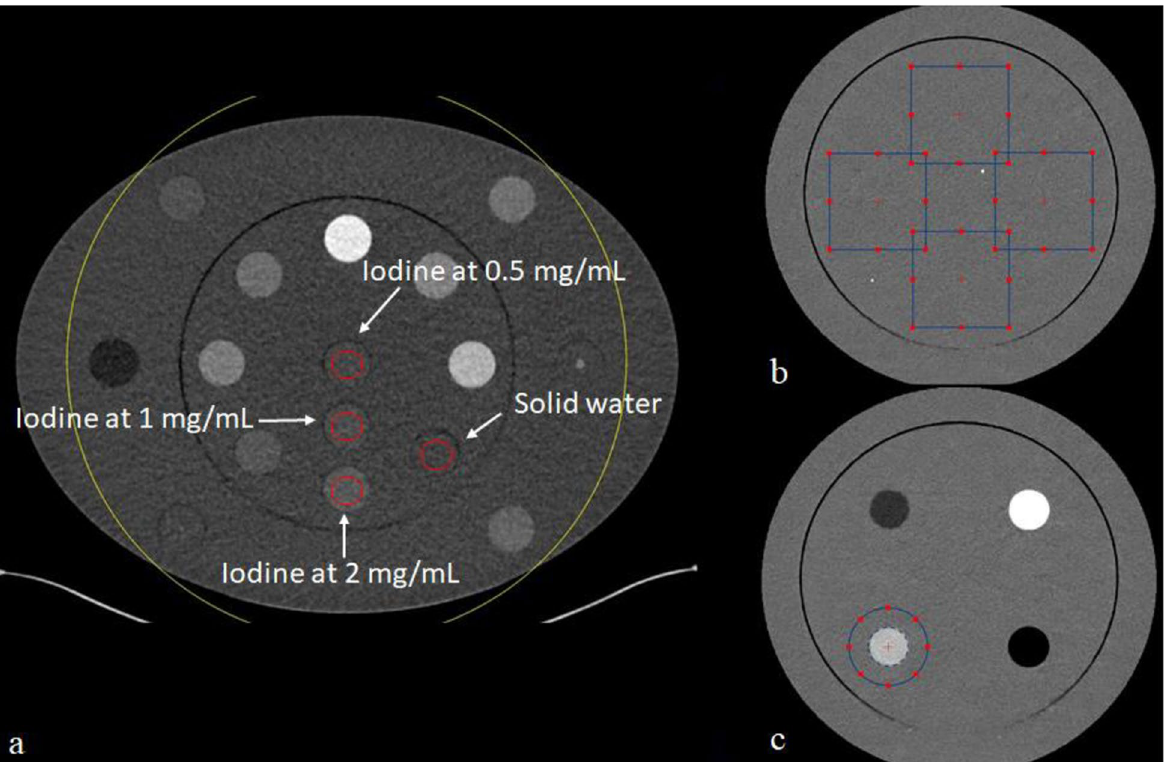
Fig. 2 Regions of interest (ROIs) placement on the images. a ROI to measure the iodine contrast relative to solid water in the multienergy phantom. b ROI placed on the uniform module of the ACR phantom to compute the noise power spectrum (NPS). c. ROI placed on the acrylic insert of the ACR phantom to compute the task‑based transfer